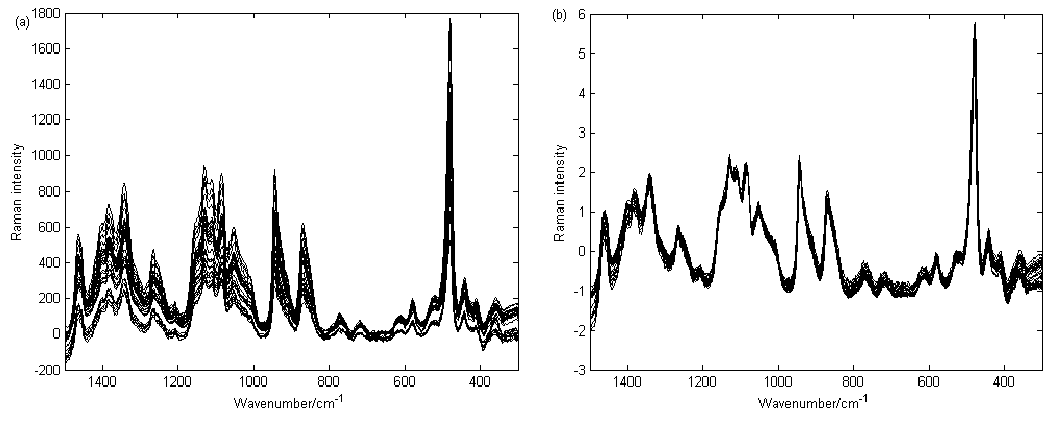
Figure 3. Original ( a ) and normalized ( b ) spectra of 31 rice grain samples. The baseline of the original spectra has been stripped off before normalization.